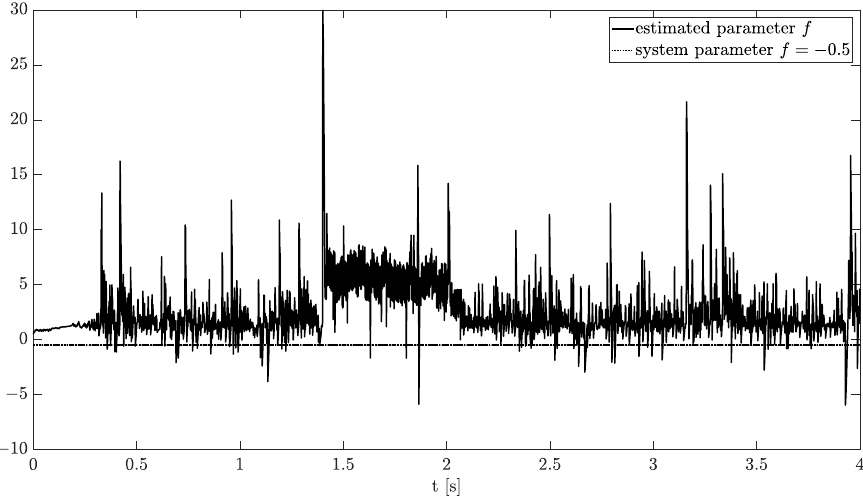
Figure 3. Original and estimated parameter obtained using the dual estimation